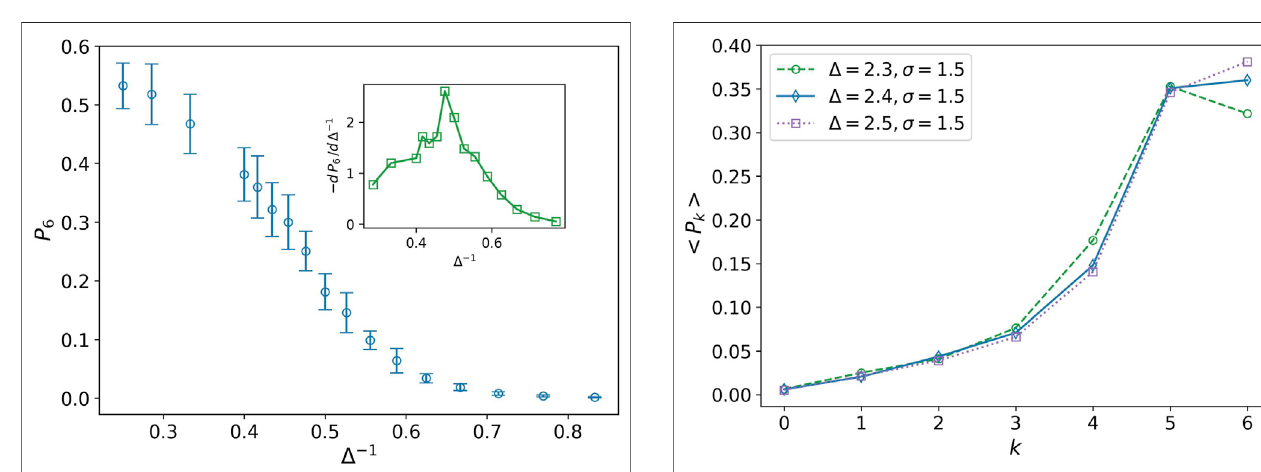
FIGURE 6 | Average of the degree distribution in terms of degree. Average of the degree distribution is plotted for three values Δ = 2.3, Δ = 2.4, and Δ = 2.5. The attraction range has a fi xed value, σ = 1.5. Every point is obtainedbyaveragingover 20simulationvaluesof P k .Theerrorbars are eliminated for clarity of the